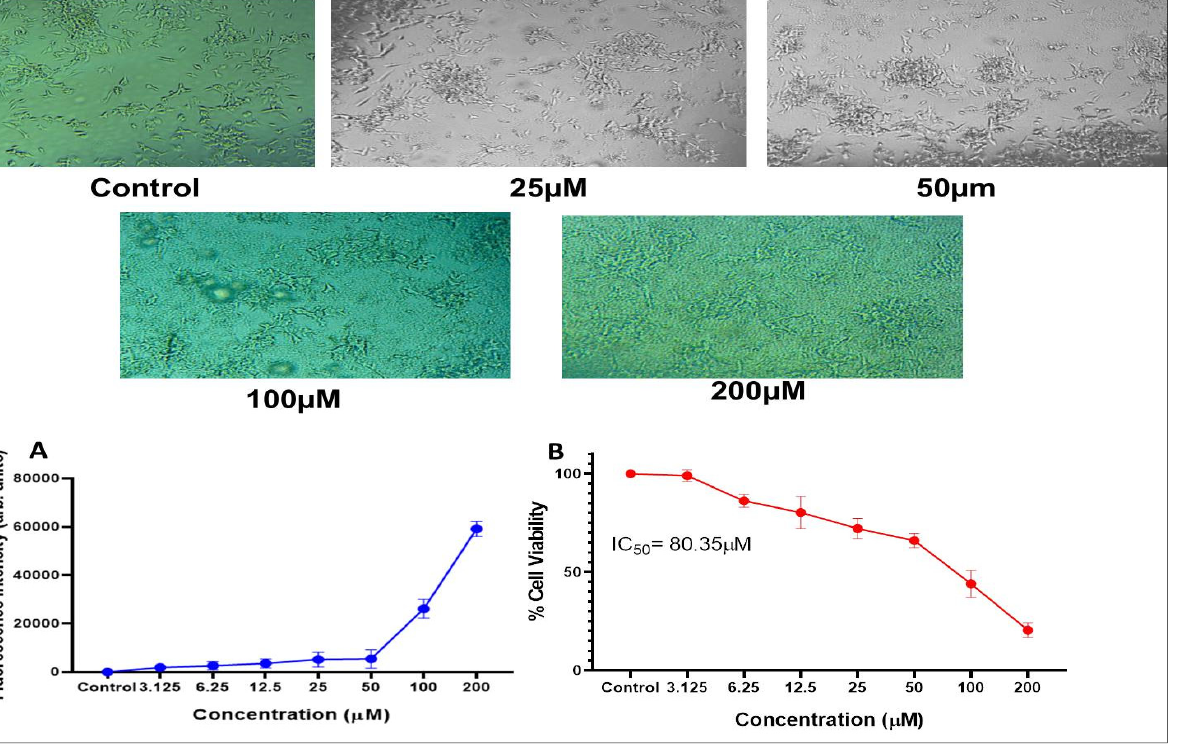
Figure 3. Effect of different A β 1-42 concentrations on the viability of SHSY5Y cells ( A ) ThT assay ( B ) MTT assay (data points mean ± SD, n = 3).